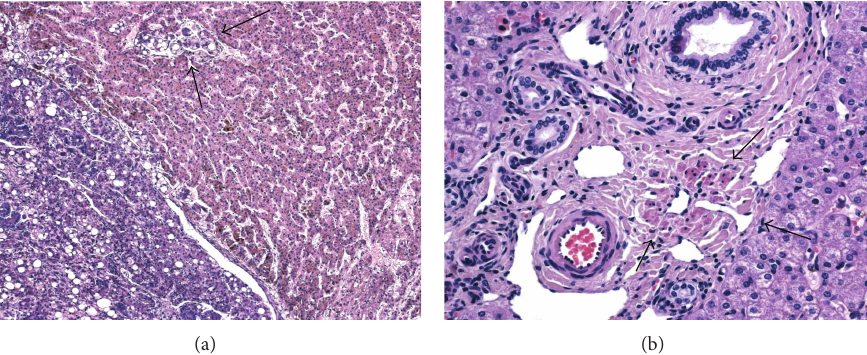
Figure 3: 𝛽 -catenin-activated HCA with malignant transformation in a young boy with congenital absence of the portal vein. Microscopic view of the adenoma on the right and of the hepatocellular carcinoma on the left with vascular invasion indicated by arrows ((a), Obj × 10). The adjacent nontumoral liver shows hypoplastic portal vein branches in middle-sized portal tracts (arrows) ((b), Obj ×